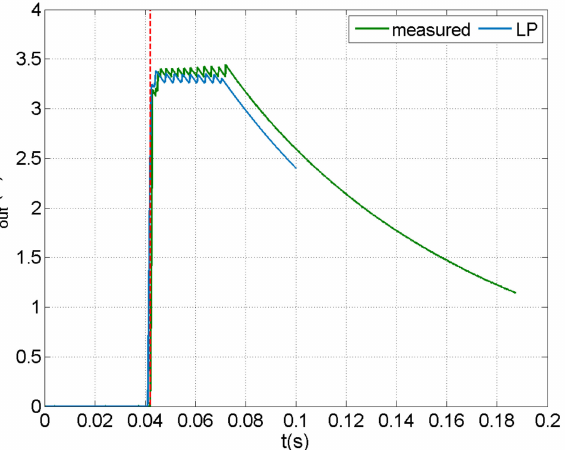
Figure 11. Predicted and measured voltage in the output of the discharging subcircuit in the case of a PEH circuit with capacity of 2.7 µ F.